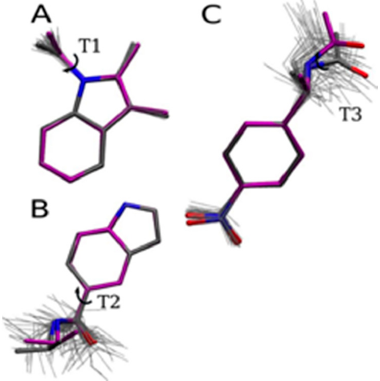
Figure 4. SR1664 fragment structures minimized at the MP2 level (carbon atoms in gray) and classically minimized (carbon atoms in purple), superposed with snapshots extracted from the MD simulations in vacuum (thin gray lines): ( A ) T1 fragment; ( B ) T2 fragment and ( C ) T3 fragment.